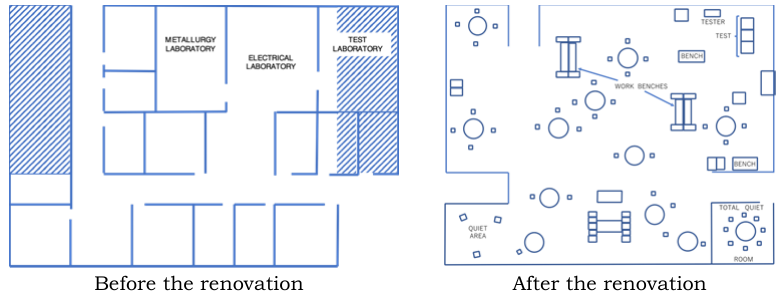
Figure 1. Office layouts before and after the renovation in Allen’s office